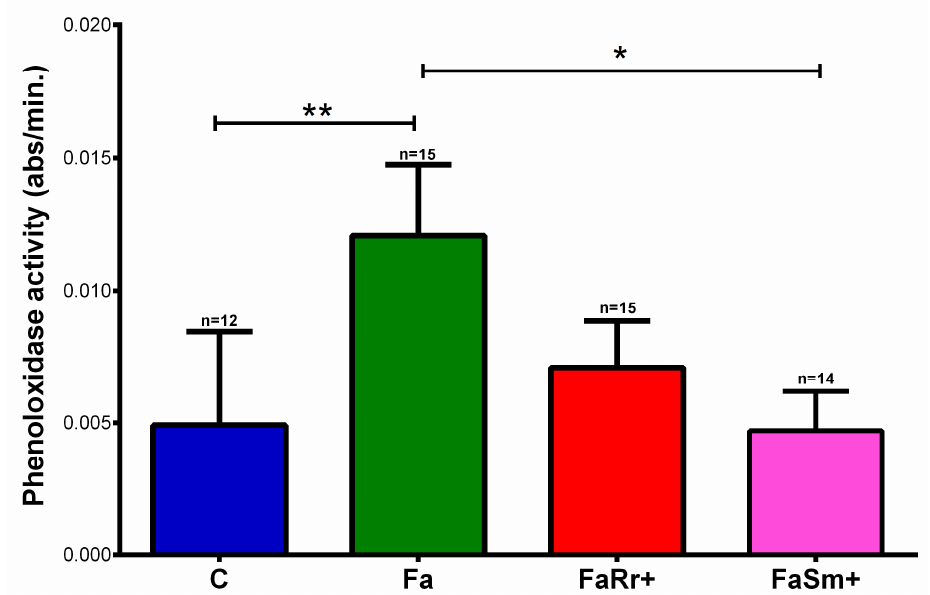
Figure 3. Phenoloxidase activity in the hemolymph of 5th instar nymphs of Rhodnius prolixus at 7 days after feeding. The treatments and group names are as described in Figure 1. Bars represent the mean ± SEM of three replicates of 5 insects; for each condition tested, n is represented above the bars. Means were analyzed by one-way ANOVA with the post-hoc Tukey test, * p < 0.05; ** p < 0.01.